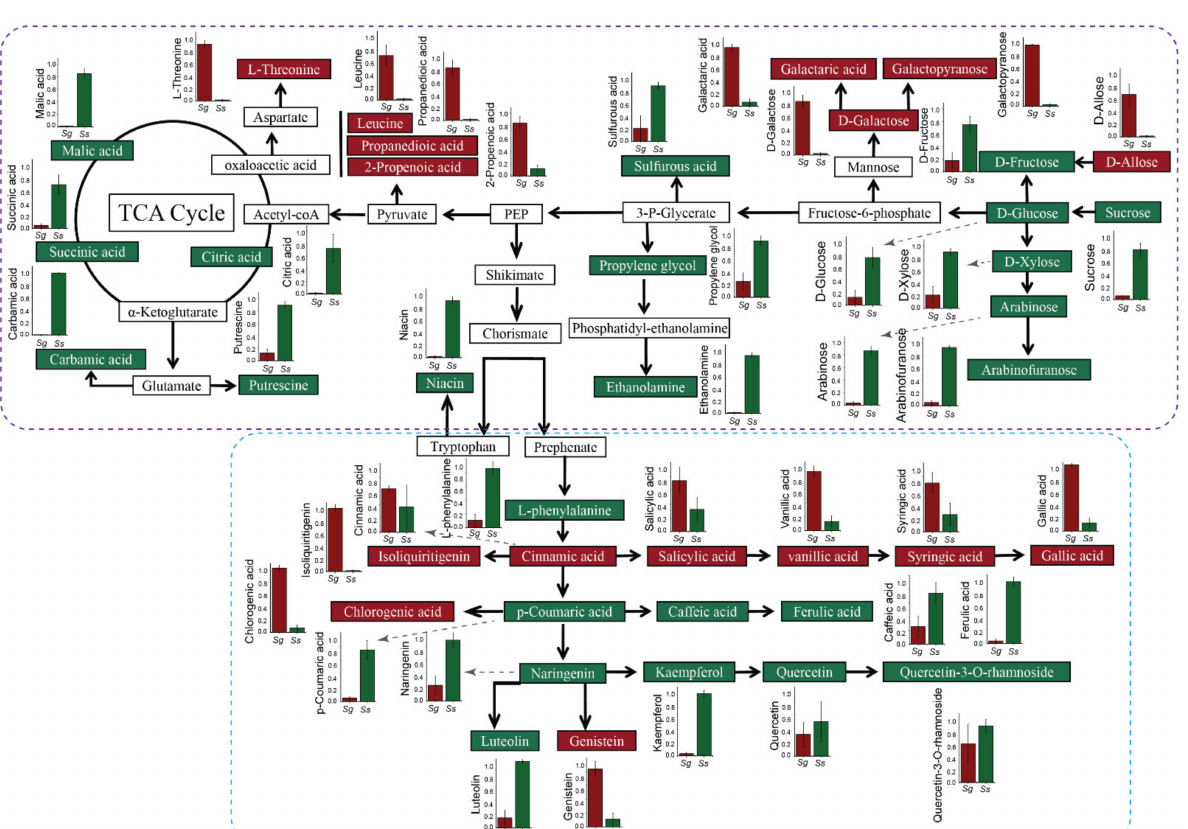
Figure 6. Visualization of primary metabolites and phenolic metabolite dynamics in S. glauca and S. salsa metabolic pathway maps. Primary metabolic pathways are shown in purple boxes, while phenolic biosynthetic pathways are shown in blue boxes. Significantly up- and downregulated metabolites are indicated by red and green boxes, respectively. Sg and Ss on the X-axis represent S. glauca and S. salsa in red and green, respectively. The relative abundance of metabolites on the Y-axis is shown as normalized values transformed by MetaboAnalyst software. After normalization, the lev- els of primary metabolites and phenolic metabolites were averaged across three biological